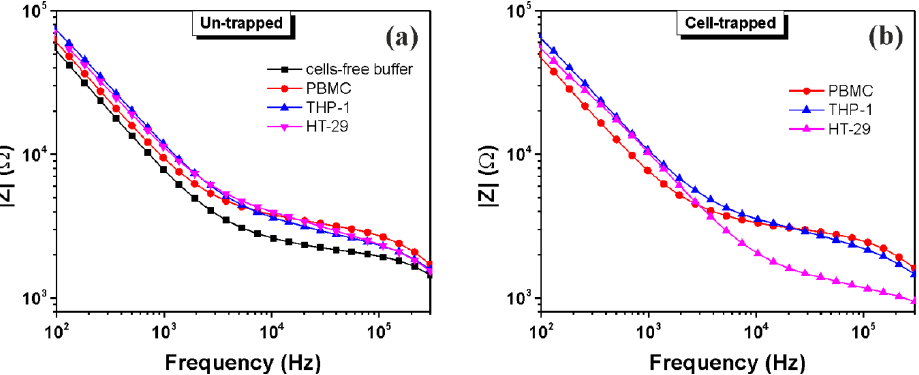
Figure 5. Impedance magnitude of different cell types (PBMC, THP-1 and HT-29) suspended in buffered sucrose solution, before ( a ) and after cells trapping (DEP: 12 Vpp at 1MHz for about 5 min) ( b ). At low frequencies, the current is forced to flow around the insulating cell membranes, while at higher frequencies, the current penetrates the cell membranes and flows through intracellular and extracellular fluid [16,17]. Therefore, differences noticed at frequencies of below 30 kHz between human peripheral blood mononuclear cells and cell lines (THP-1 and HT-29) could be attributed to the surface morphological features of the cell membranes and to the electrode surface area, which is covered with cells, i.e., cells radii [13]. The colon cancer cells (HT-29) exhibited a lower impedance magnitude (0.95–3.7 k Ω ) than normal cells (PBMC and THP-1) in the frequency range from 3 to 300 kHz. Other